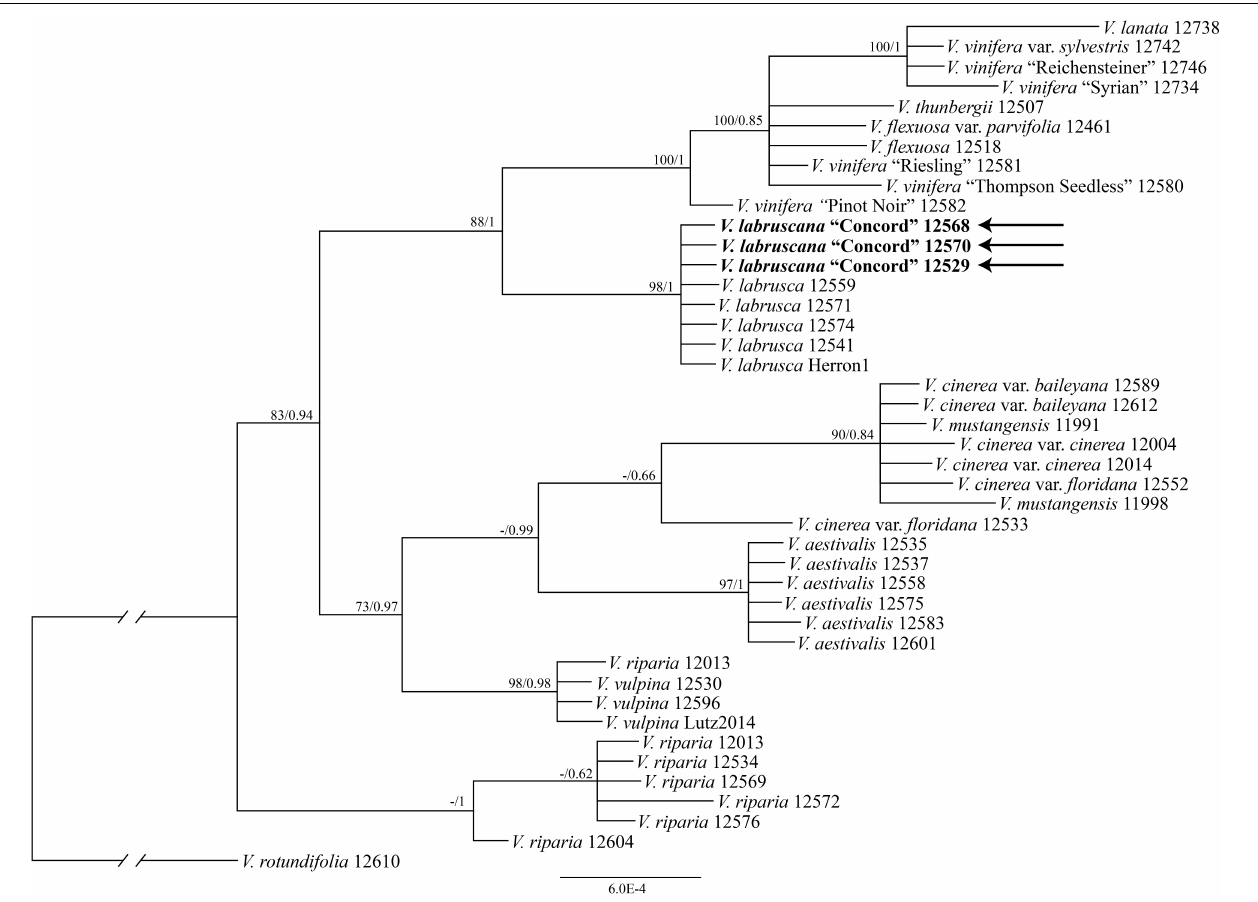
FIGURE 3 | Phylogenetic relationships of the Concord grape and its close allies using combined nuclear sequences and Bayesian inference. Numbers associated with the branches are ML bootstrap support and Bayesian posterior probability